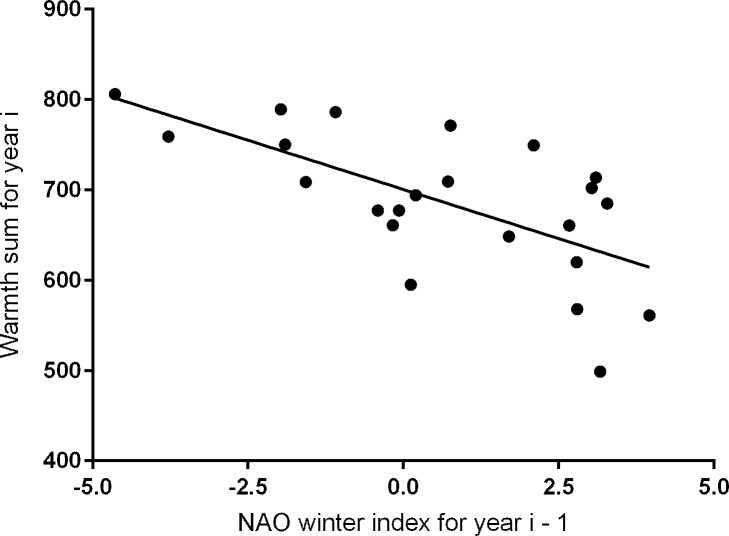
Time-lagged relationship between local spring warmth (warmth sum) and the NAO winter index.Values of the NAO WI are for the winter of the year before, i.e. warmth sum for year i, NAO WI for year i-1. Least squares regression equation is: warmth sumi = 701–21.8 NAO WIi-1, R2 = 0.426, P < 0.001.